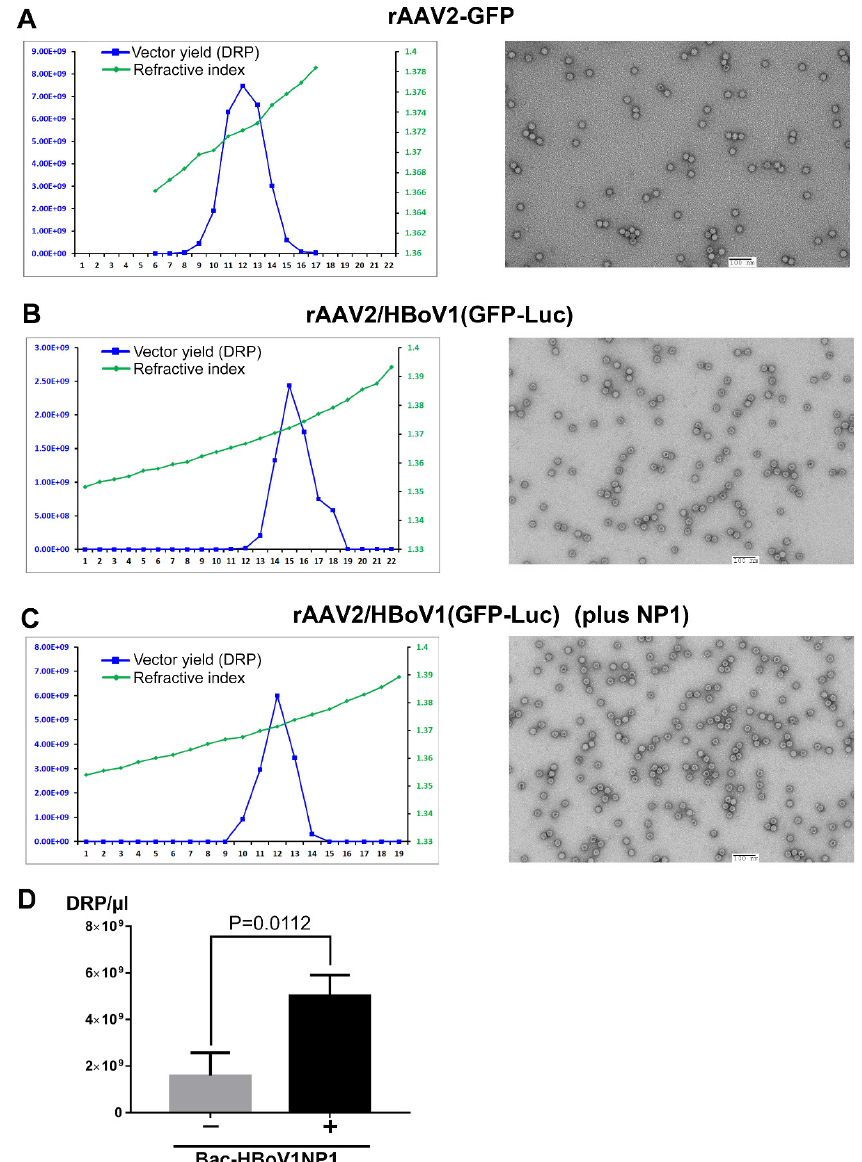
Figure 3. Purification of rAAV2 and rAAV2/HBoV1 vectors produced from BEV-infected Sf9 cells. ( A – C ) Vector production. Sf9 cells were co-infected with Bac-AAV2ITR-GFP and Bac-AAV2Rep-Cap (A), Bac-AAV2ITR-GFP-Luc and Bac-AAV2Rep-HBoV1Cap ( B ), or Bac-AAV2ITR-GFP-Luc, Bac-AAV2Rep-HBoV1Cap, and Bac-HBoV1NP1 ( C ). Cell lysates from infected cells were fractionated by CsCl equilibrium ultracentrifugation. Left panel: qPCR analysis was used to determine the DRP in each fraction of 0.5 ml (blue line); the density of each fraction was determined as refractive index and is shown by the line in green. Right panel: transmission electron micrographs of rAAV2 or